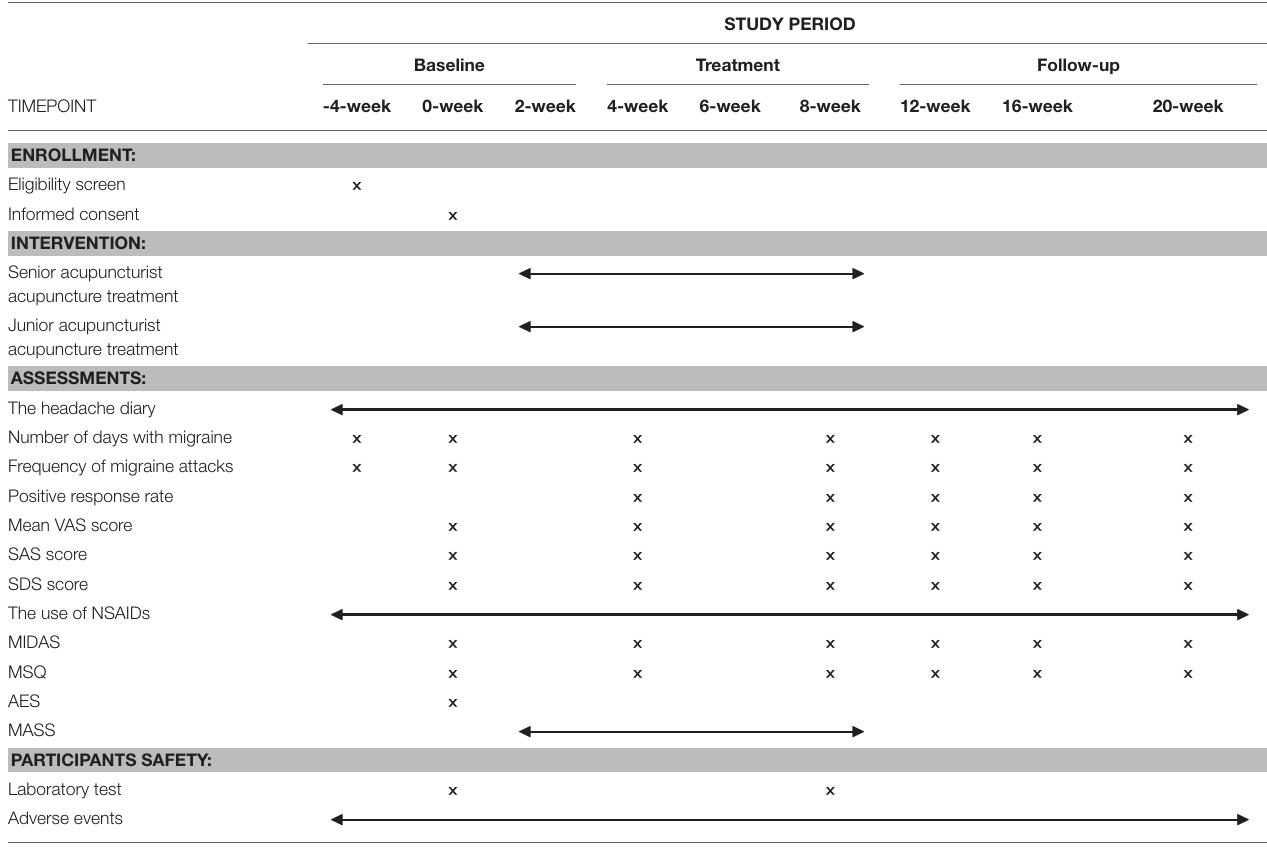
TABLE 1 | Standard Protocol Items: Recommendations for Interventional Trials (SPIRIT) schedule of the